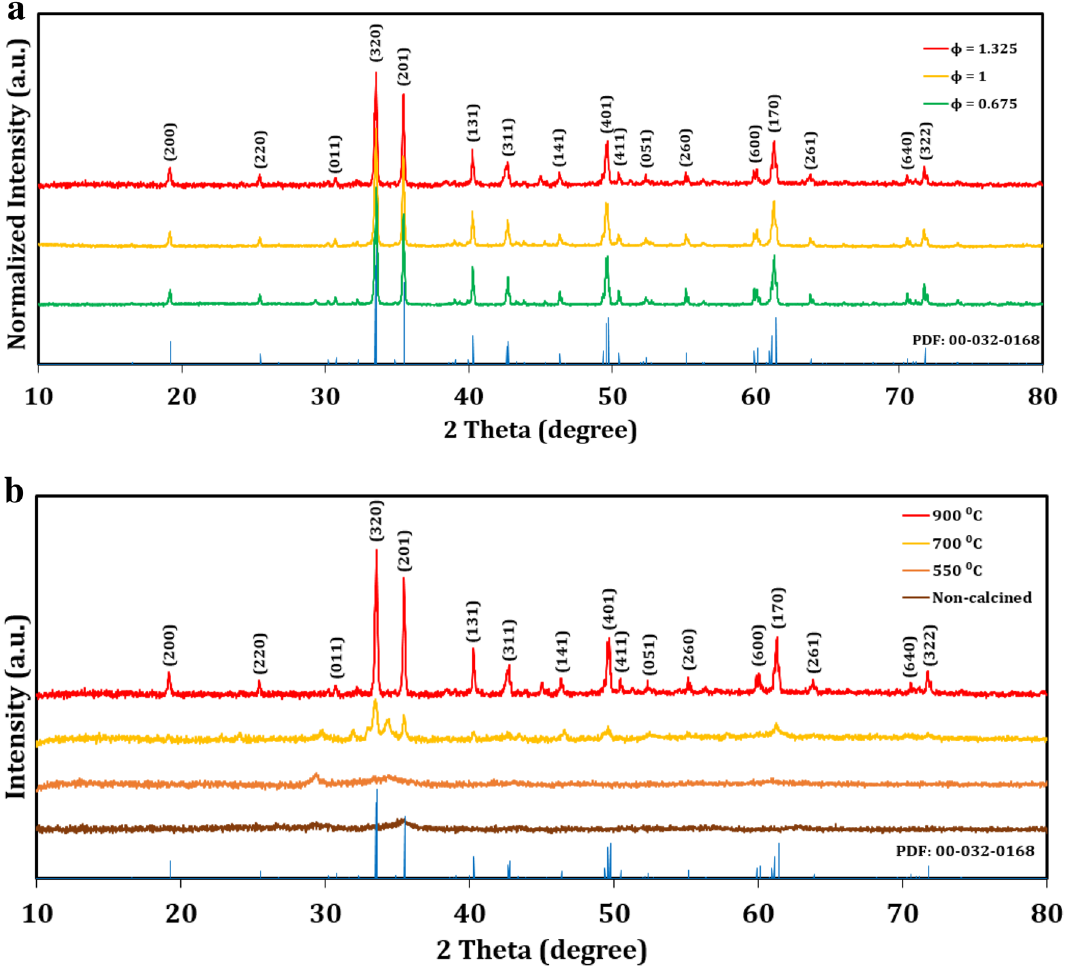
Figure 2. XRD patterns of CaFe 2 O 4 : ( a ) synthesized at increasing ϕ and calcined at 900 °C, ( b ) synthesized at ϕ = 1.325 and calcined at different temperatures. Spectra have been vertically scaled and offset for